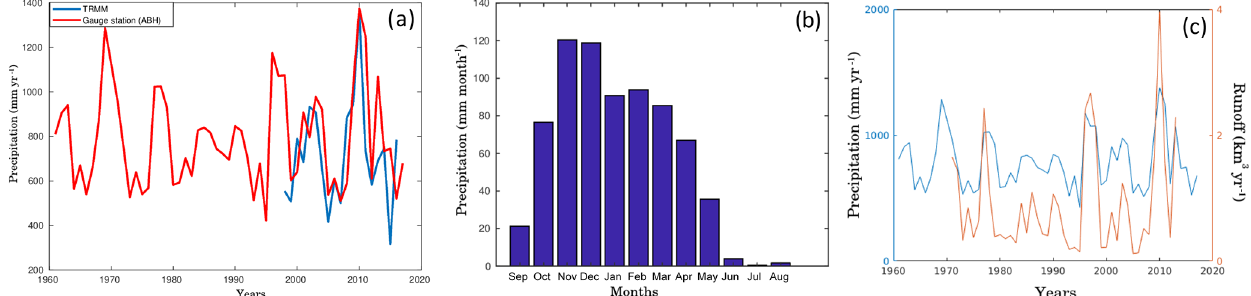
Figure 6. The hydrology of the Loukkos watershed. (a) Interannual variability of precipitation and comparison with TRMM. (b) Monthly variability of precipitation. (c) Annual precipitation vs. annual runoff.